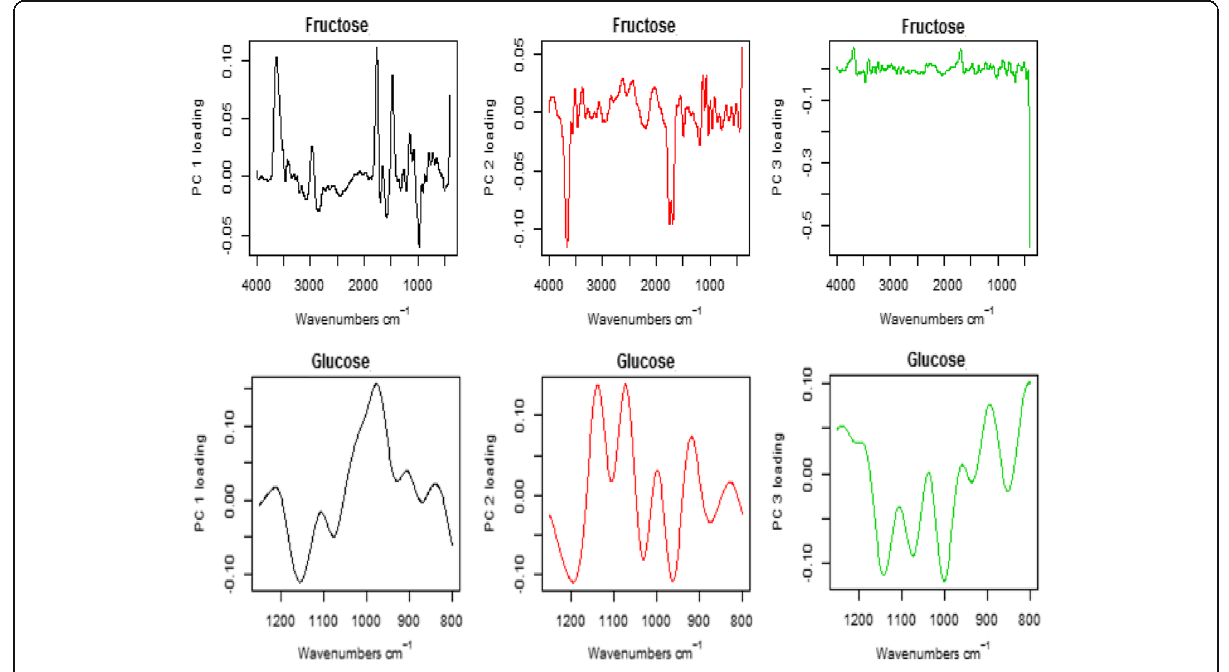
Fig. 3 DRIFTS-based mango pulps classification by a cultivar and b site using PCA on first derivative